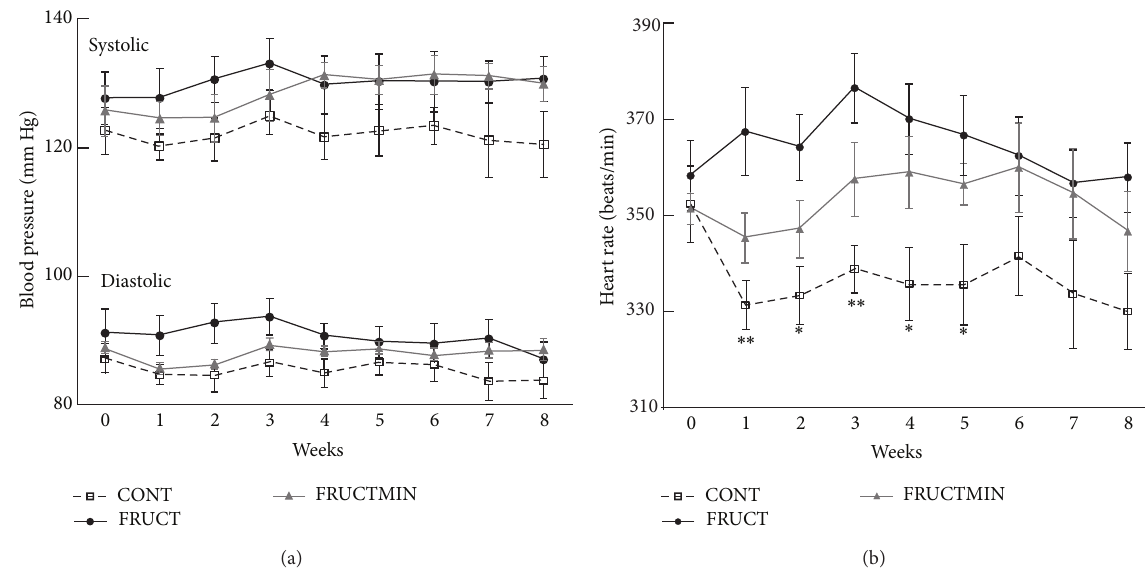
Figure 4: (a) Systolic blood pressure (mm Hg; 𝑛 = 4–7) and diastolic blood pressure (mm Hg; 𝑛 = 4–7), and (b) heart rate evolution (beats/min; 𝑛 = 4–7; ∗ 𝑃 < 0.05 CONT versus FRUCT; ∗∗ 𝑃 < 0.01 CONT versus FRUCT), during the dietary intervention. Results were expressed as mean ± standard error of the mean. CONT: control; FRUCT: 10% fructose in tap water; FRUCTMIN: 10% fructose in natural mineral-rich water.